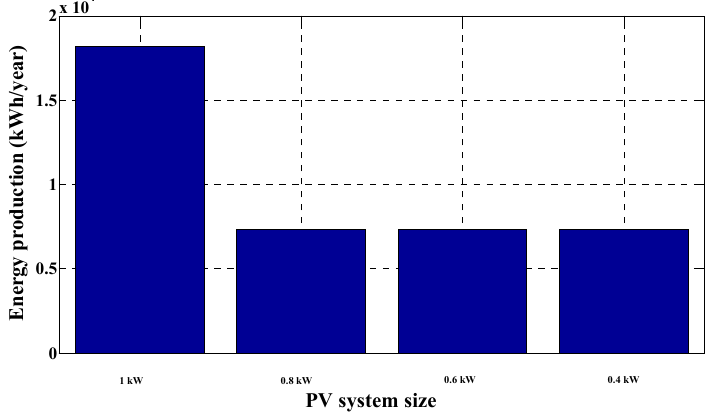
Figure 11. The sharing cost of each component of the system.